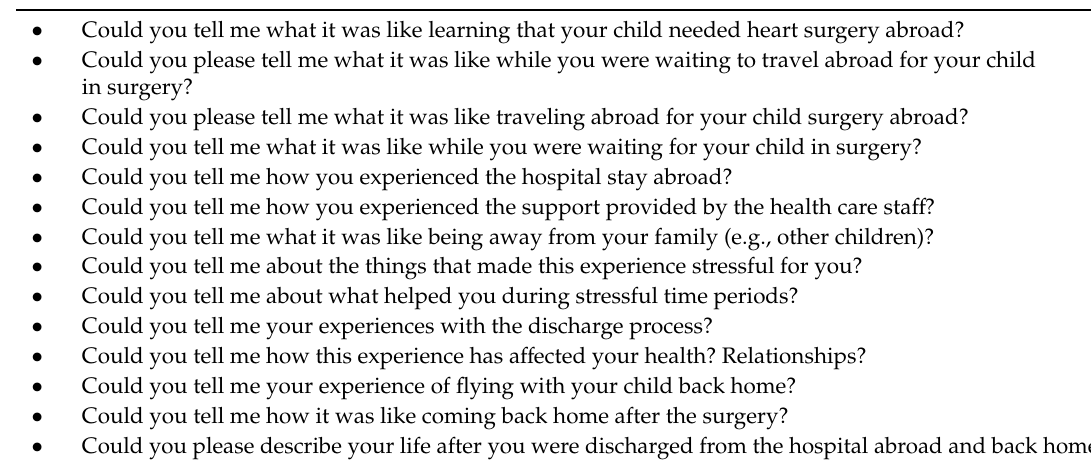
Table 2. Selected interview